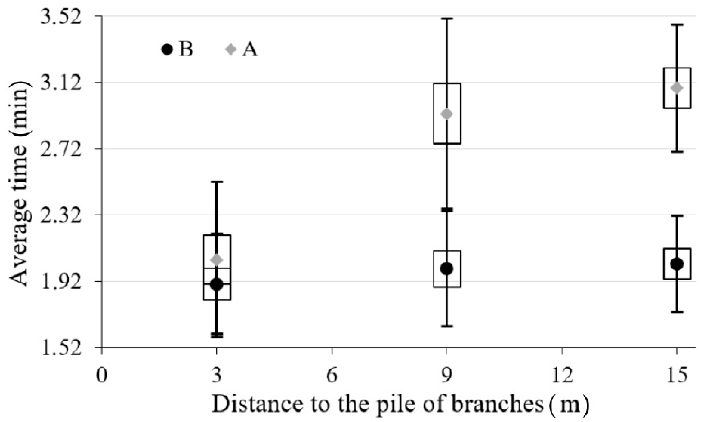
Figure 9. Mean time to fill up the container for chips; error bars are ± standard deviation, rectangles are ± standard error; A—for one operator, B—for two operators.